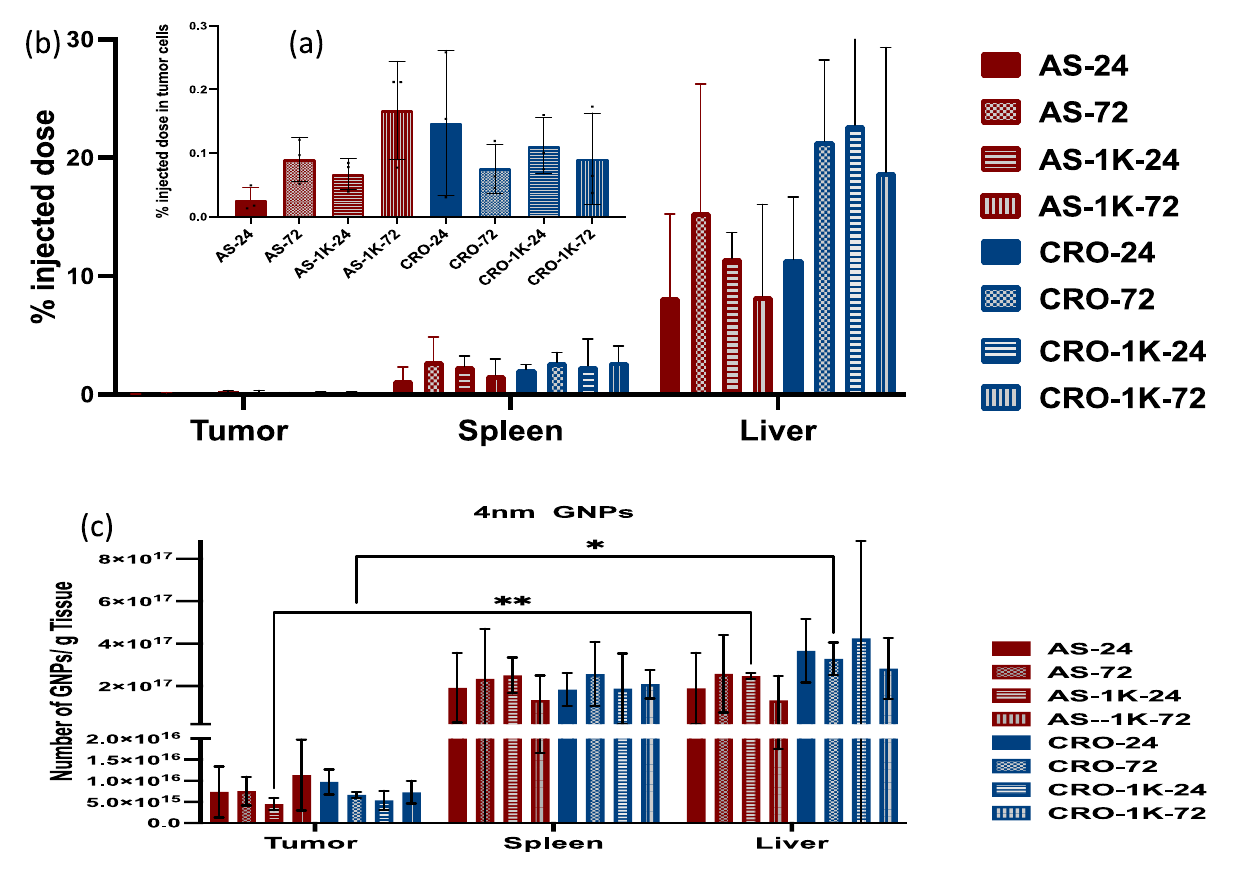
Figure 7. Quantification of 4 nm GNP accumulation in the tumor, liver, and spleen of mice that were injected with non-PEGylated and PEGylated (PEG Mw: 1 kDa) particles 24 and 72 h post-injection. ( a ) The percentage of the injected dose in tumor cells. ( b ) The percentage of the injected dose in the liver and spleen. ( c ) The number of GNPs/g tissue. Each data point represents the mean ± standard deviation (SD) of triplicate experiments. * denotes p < 0.05 and ** denotes p < 0.01.